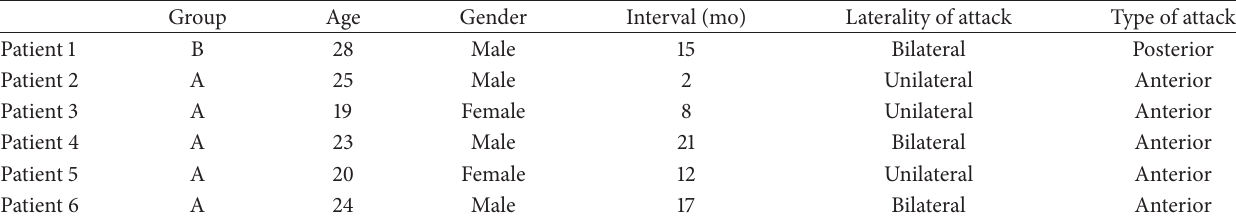
Table 1: The patients experienced uveitis attack during their followup.